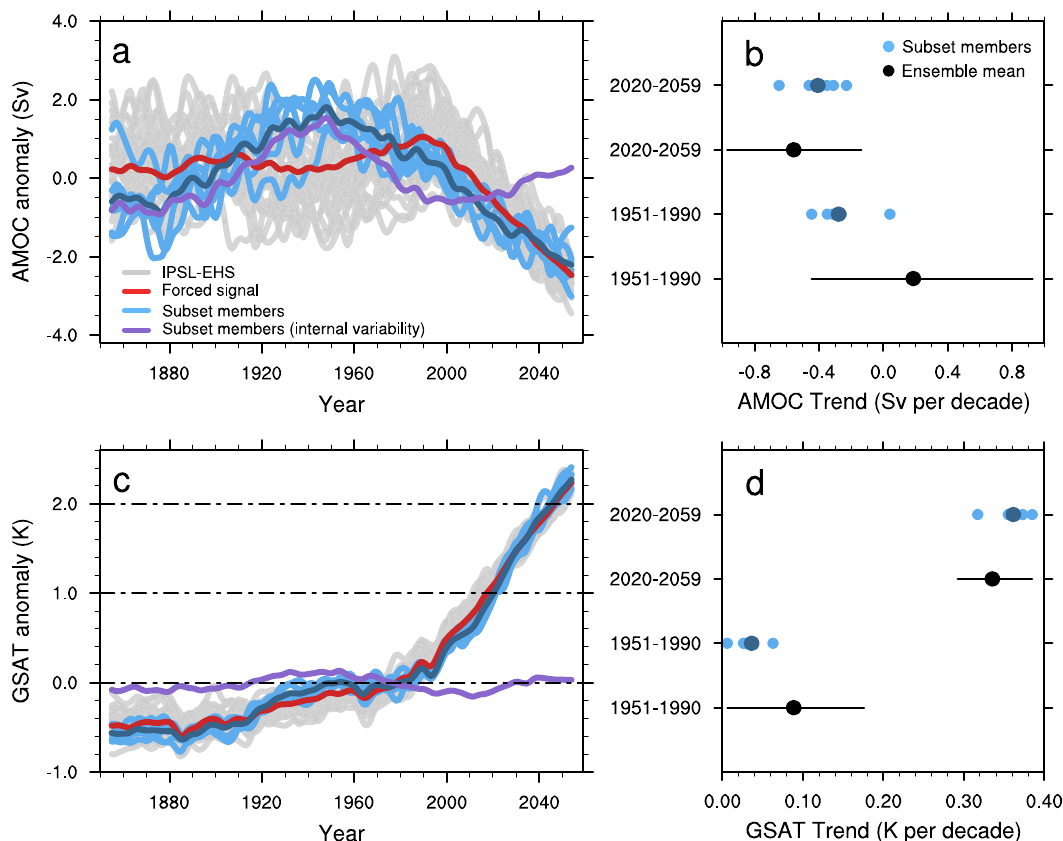
Fig. 5 Implication for near-future AMOC and GSAT change. a Time evolution of the low-pass fi ltered Atlantic Meridional Overturning Circulation (AMOC) anomaly (Sv) relative to the 1900 – 2018 period for the IPSL ensemble of extended historical simulations (IPSL-EHS) (gray), the ensemble mean (red), the subset of members identi fi ed in Fig. 2 (member #14, 5, 25, 29, 4 and 30 in light blue), the subset mean (dark blue) and the mean internal variability (calculated by removing the ensemble mean for each member) of the subset of members (purple). c Same as a but for the Global near-Surface Air Temperature (GSAT) anomaly (K). b AMOC trends (Sv per decade) in IPSL-EHS (black), with the ensemble mean (black dot) and the full minimum- maximum range (black line) and the subset of members (light blue), with the subset mean (dark blue). d Same as c but for